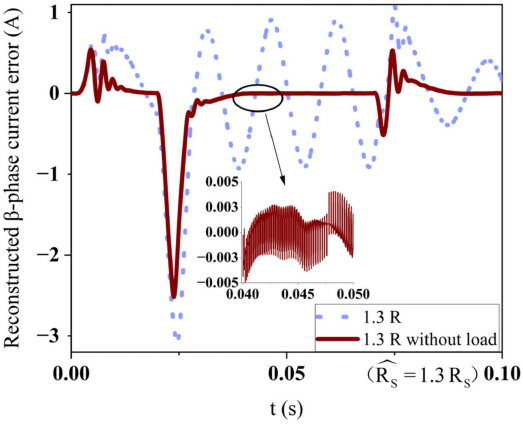
Figure 12. Mismatched β -axis current